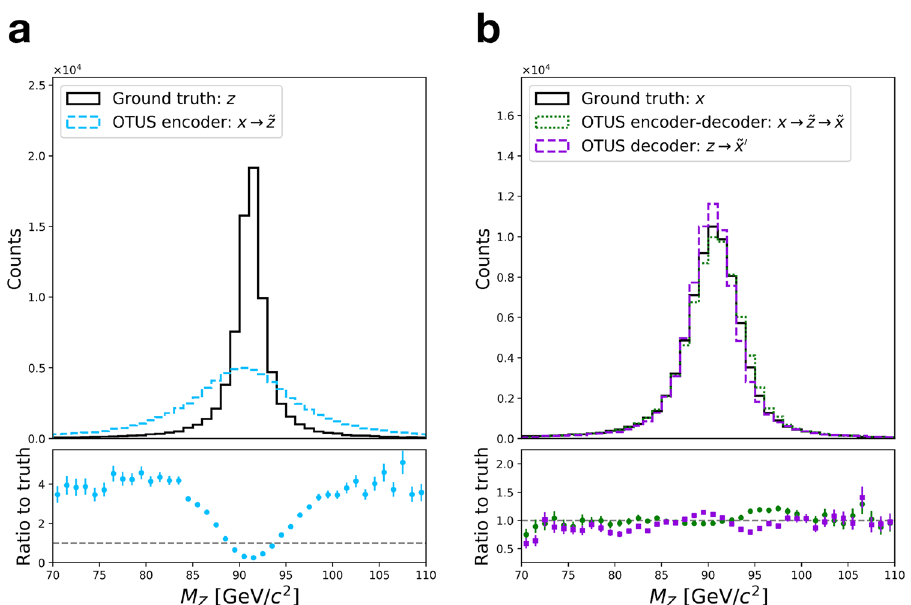
Figure 5. Performance of OTUS for Z → e + e − decays in a physically important derived quantity, the invariant mass of the electron-positron pair, M Z . ( a ) Matching of the M Z distribution in Z . It shows distributions of samples from the theoretical prior, { z ∼ p ( z ) } (solid black), as well as the output of the encoder, {˜ z } ; the encoder transforms samples of testing data in experimental space, X , to the latent space, Z , and is shown as x → ˜ z (dashed cyan). ( b ) Matching of the M Z distribution in X . It shows the testing sample { x ∼ p ( x ) } (solid black) in the experimental space, X , as well as output from the decoder applied to samples drawn from p ( z ), labeled as z → ˜ x ′ (dashed purple). Also shown are samples passed through both the decoder and encoder chain, x → ˜ z → ˜ x (dotted green). Dotted green and solid black distributions are matched explicitly during training. Enhanced differences between dashed purple and solid black indicate the encoder’s output needs improvement, as p E ( z ) does not fully match p ( z ). If performance were ideal, the distributions in every plot would match up to statistical fluctuations. Note that this projection was not explicitly used during training, but was inferred by the networks. Residual plots show bin-by-bin ratios with statistical uncertainties propagated accordingly (see